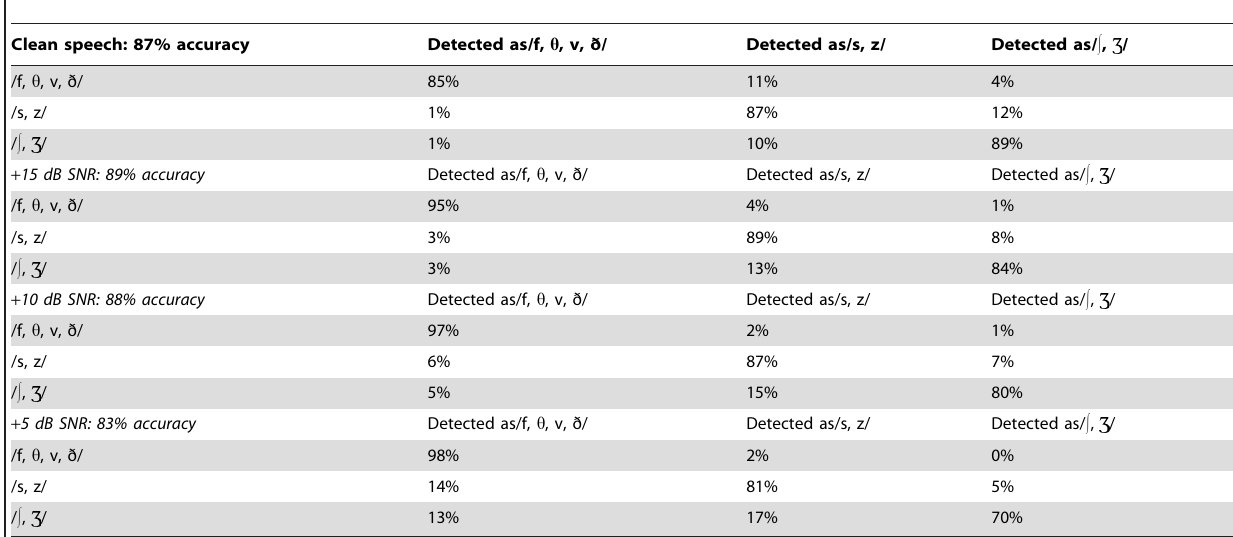
Table 2. Confusion matrices for fricative classification in quiet and at three SNRs using Gammatone(14).